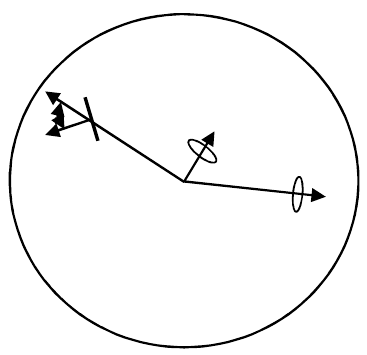
Figure 6. Our Local Group CNO spiral galaxy orientation. Two of the three embedded spiral galaxies have spin axis which are radially aligned to the CNO center, while the Milky Way has a canted spin axis from the center.